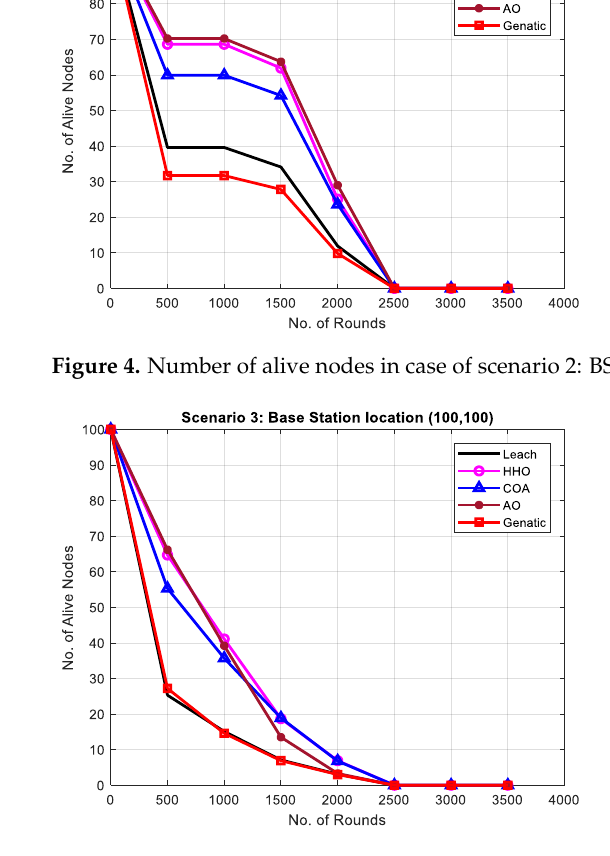
Figure 5. Number of alive nodes in case of Scenario 3: BS at (100,100).